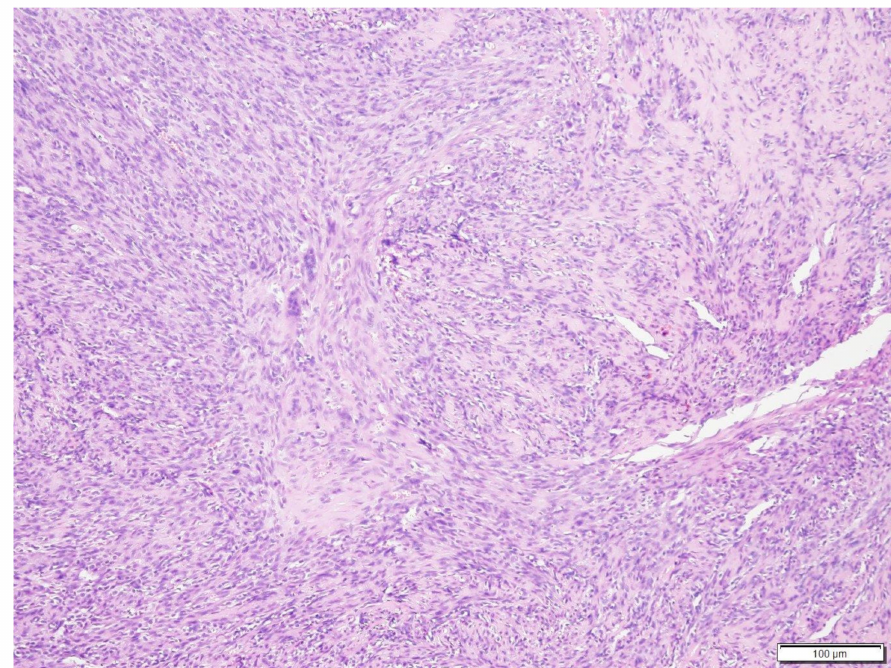
Figure 6. Histologic findings of the vertebral body mass. Neoplastic spindle cells are forming disorganized streams from fine to occasional dense fibrovascular stroma. Hematoxylin and eosin stain ( × 100 magnification).